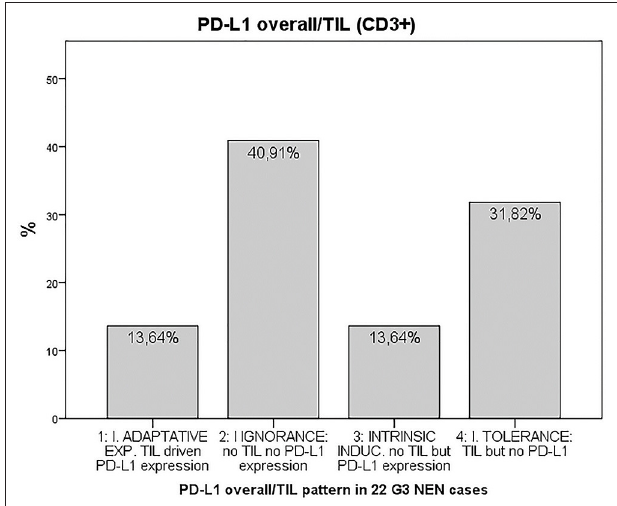
FIGURE 3 | Tumor microenvironment classification according to the PD-L1 overall/TIL (CD3 + ) pattern ( 20) in 22 G3 NEN cases. PD-L1: programmed cell death protein ligand 1, TIL: tumor-infiltrating